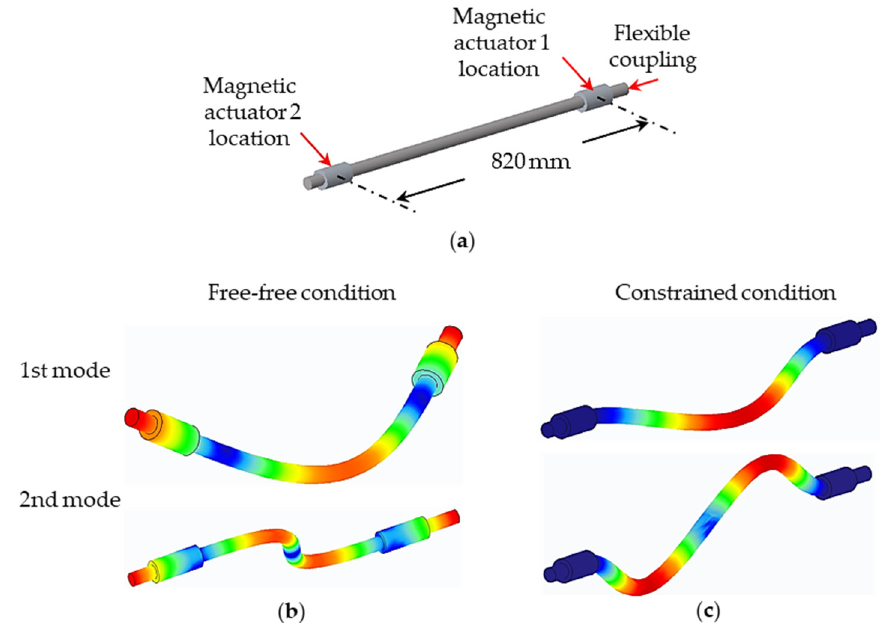
Figure 13. ( a ) Shaft configuration; ( b ) vibrational mode frequencies at: ω 1 = 117.57 Hz, and ω 2 = 353.52 Hz; ( c ) vibrational mode frequencies at: ω 1 = 236.77 Hz, and ω 2 = 646.85 Hz.